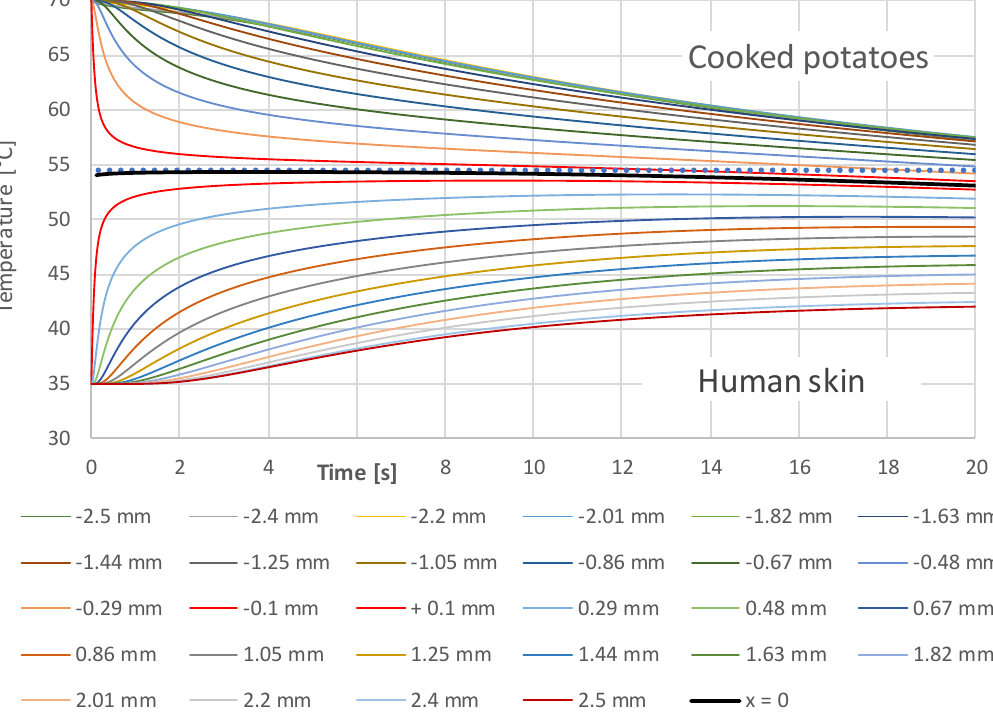
Figure 8. Temperature profiles over time in different layers of a 2.5 mm thick sample of boiled potatoes at 70 °C and human skin at 35 °C from the contact surface ( x = 0) to the surfaces ( x = ±2.5 mm). As can be seen, the constant contact temperature only occurs directly in the contact surface at x =